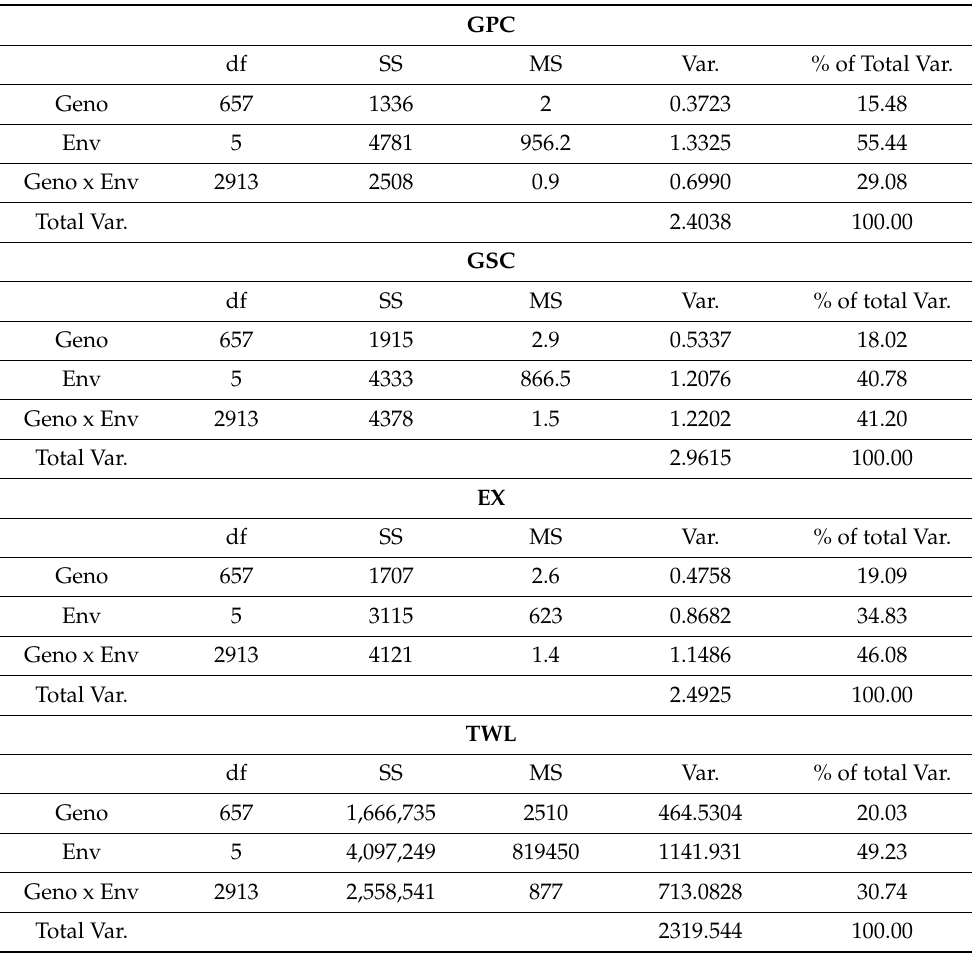
Table 1. The impact of genotype, environment, and genotype × environment on the variance of grain quality traits. GPC df SS MS Var. % of Total